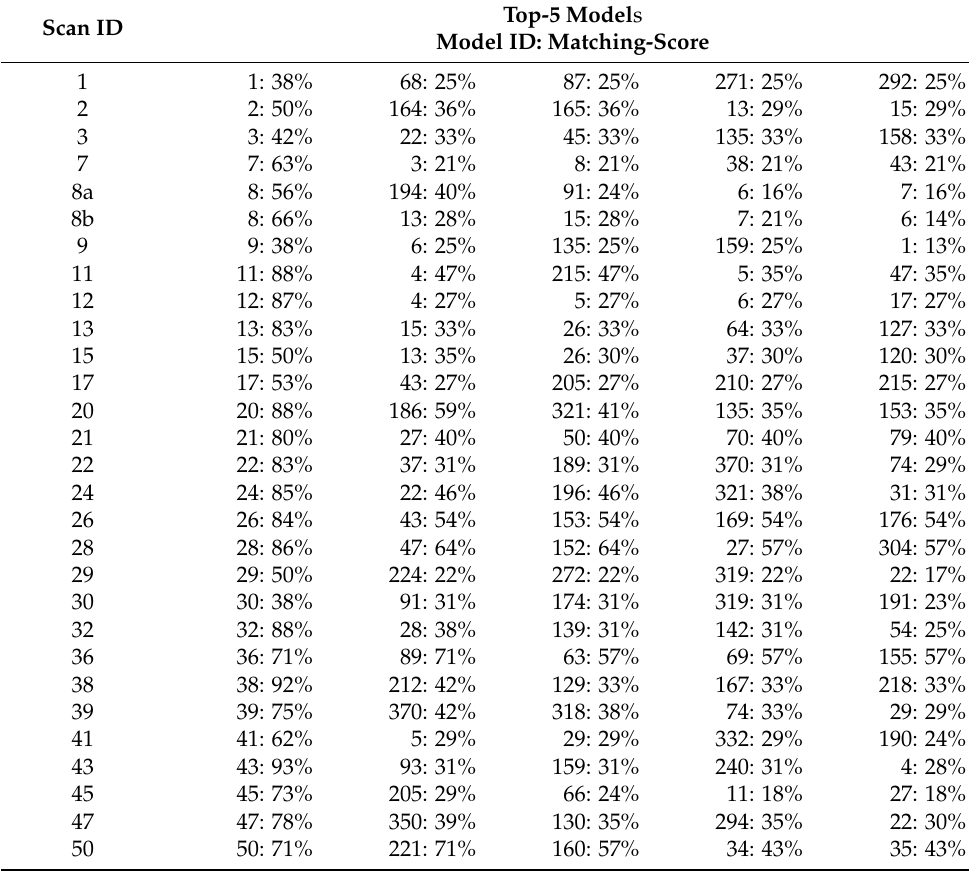
Table 1. Matching results of the method of decomposition into geometric primitives. The first column comprises the identification numbers (IDs) of the 29 scans. Notice that object 8 was scanned twice; see also Figure 10. The next 5 columns display the IDs of the 5 best matched candidates from the collection of 389 models. The percentual score is the amount of primitives in the model that match the primitives of the scan. This amount is divided by the total amount of primitives in the scan (and multiplied by